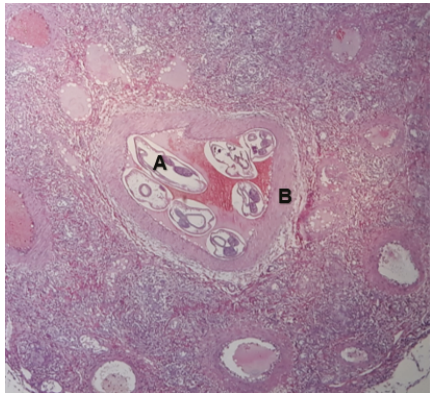
Figure 1: (A). Angiostrongylus costaricensis worm in the testicular artery lumen. (B). Blood vessel